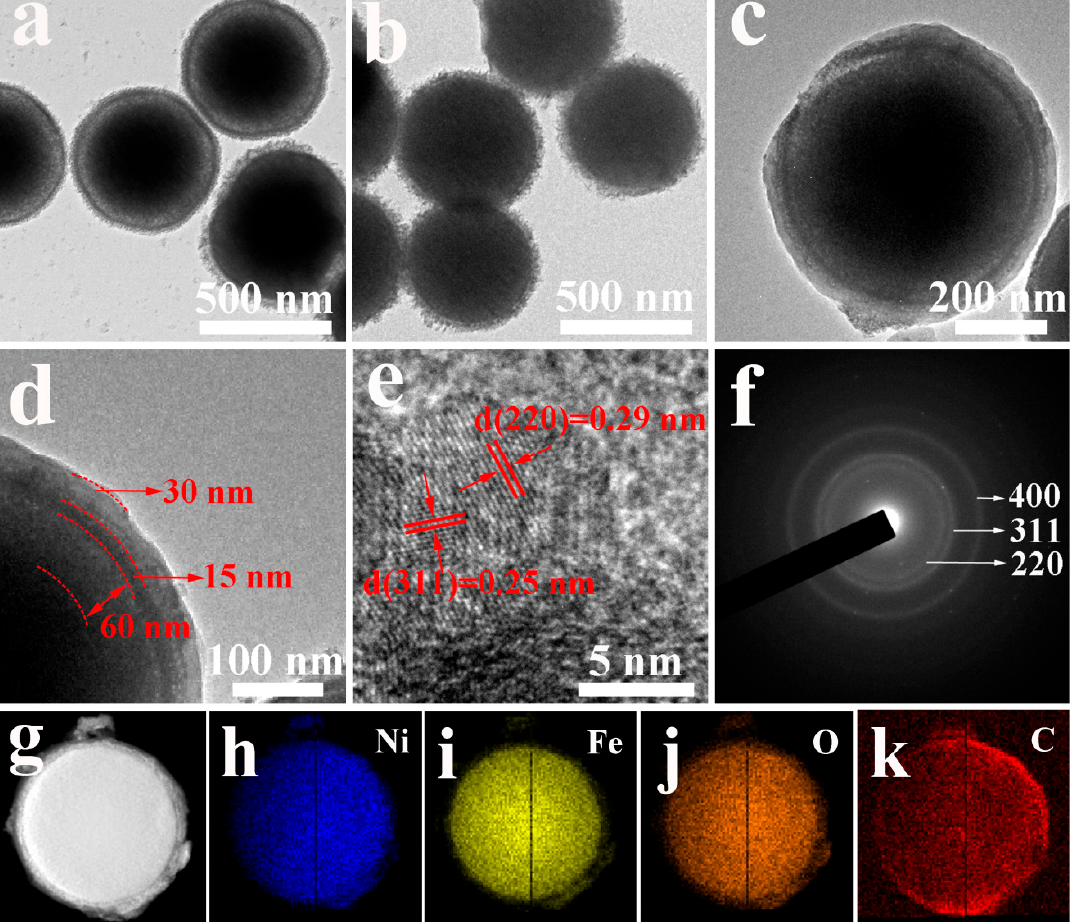
Figure 3. TEM images of ( a ) NFO-YS, ( b ) NFO-S, and ( c , d ) NFO-YS@C. HRTEM image of ( e